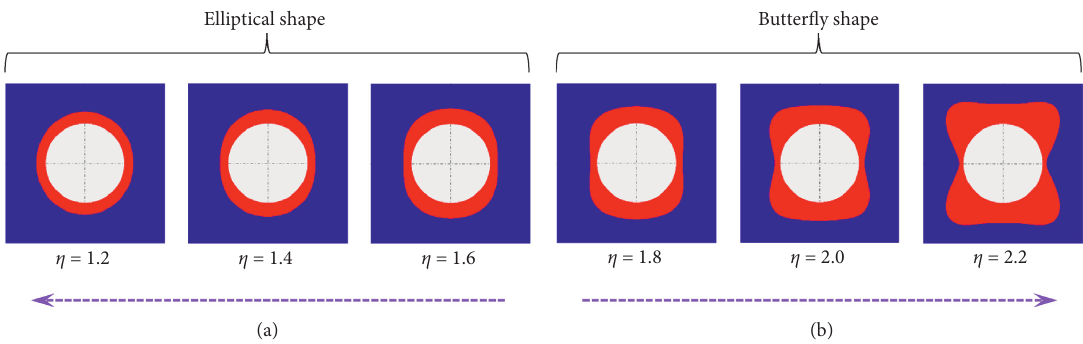
Figure 11: Evolution of the plastic area shape with confining pressure ratio ( a � 2.5m; C � 5 MPa; φ � 25 ° ; P (b) Butterfly shape.